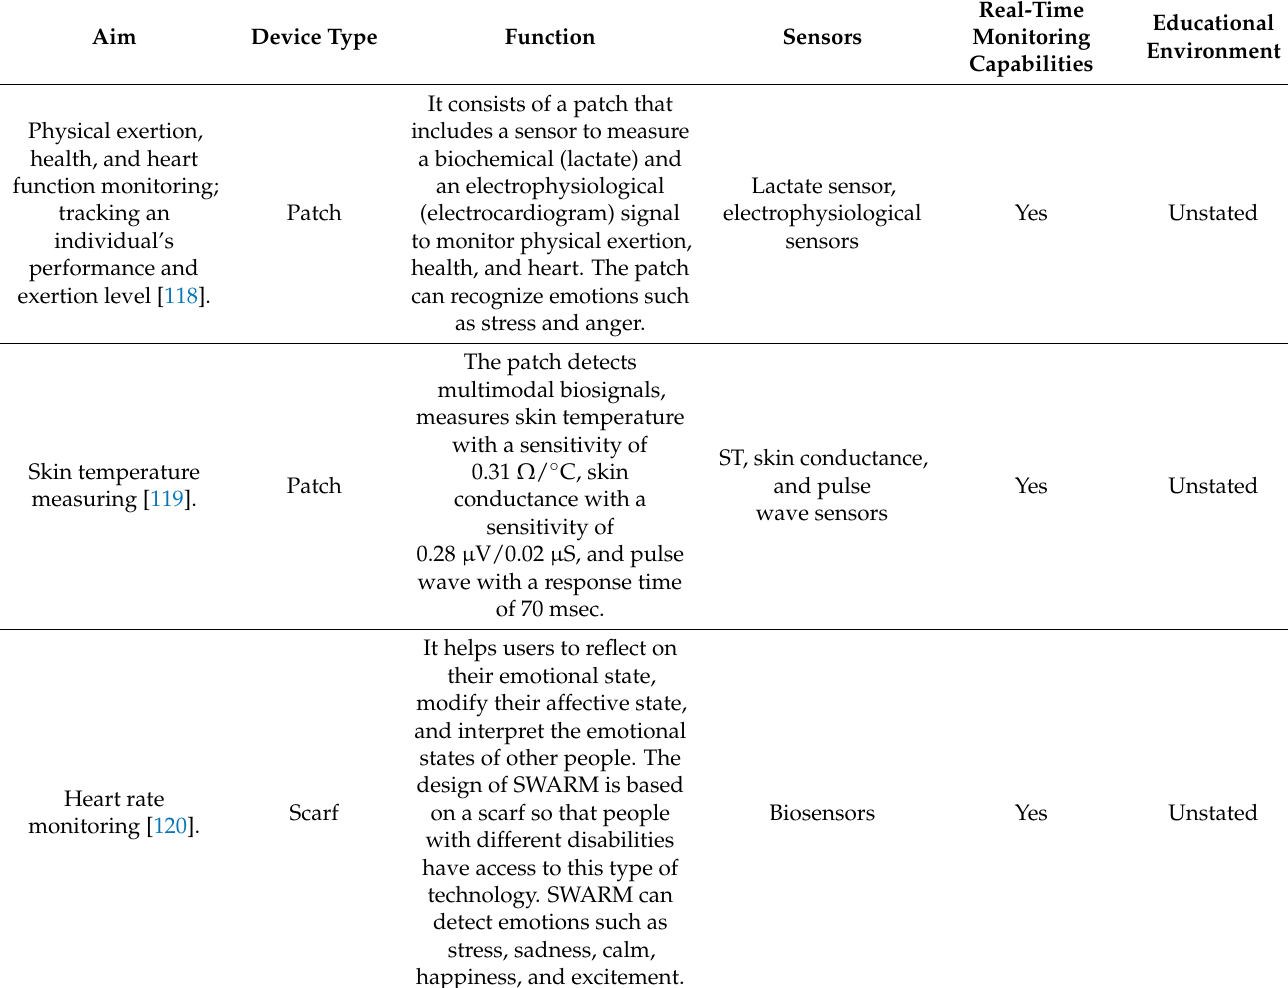
Table 4. Non-Commercial Wearables for Engagement